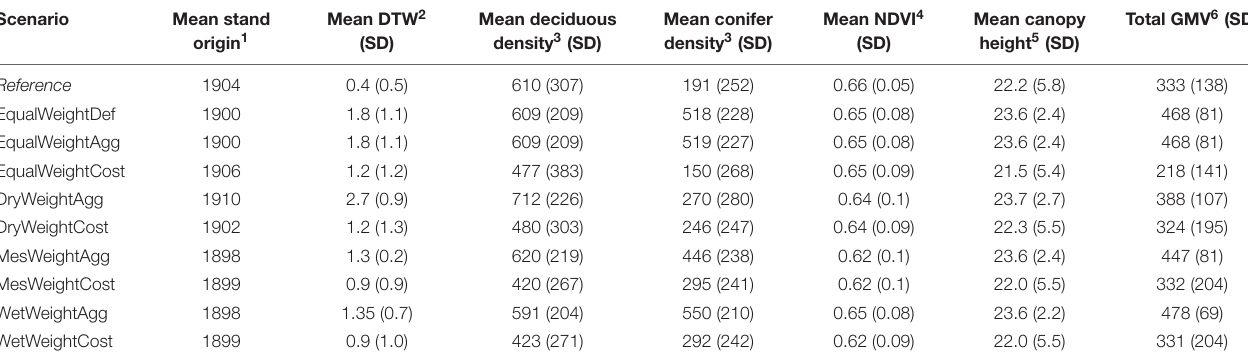
TABLE 6 | Descriptive statistics pertaining to forest attributes per